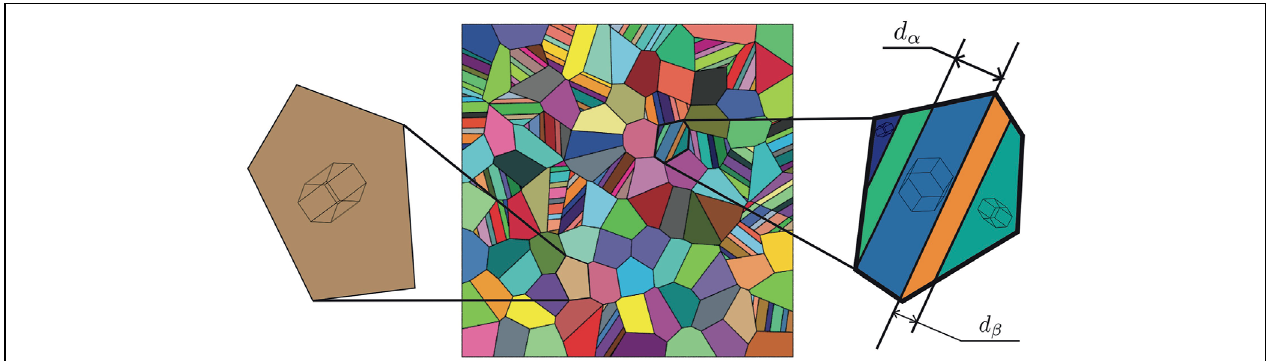
FIGURE 2 | Schematic example of microstructure